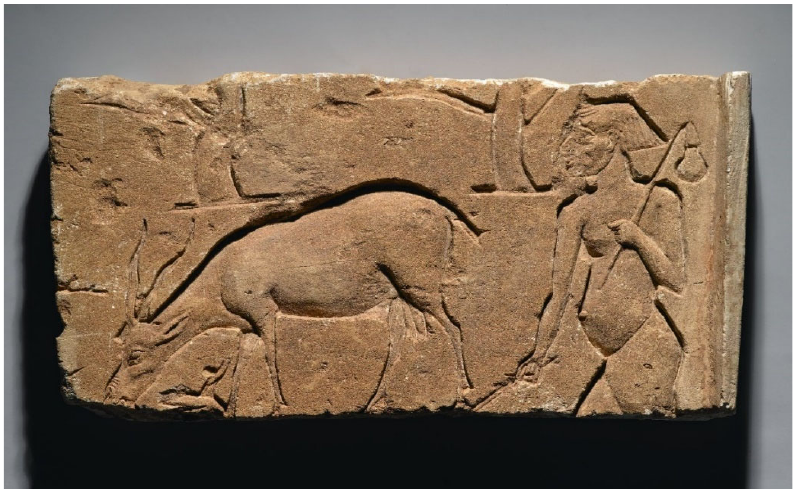
Figure 1. Relief Representation of Goatherd with Goat and Trees, ca. 1350–1333 BCE. New Kingdom, Amarna Period. Late Dynasty 18. Limestone, 8 1/4 × 16 3/4 × 2 1/2 in., 22.5 lb. (21 × 42.5 × 6.4 cm, 10.21 kg). Brooklyn Museum, Gift of the Ernest Erickson Foundation, Inc., New York, NY, USA,